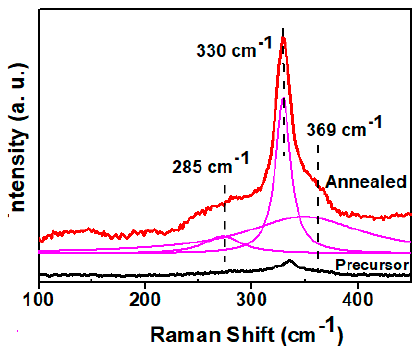
Figure 8. Raman spectrums of precursor and annealed CZTS film with fitting of the peaks using Lorentzian curve.